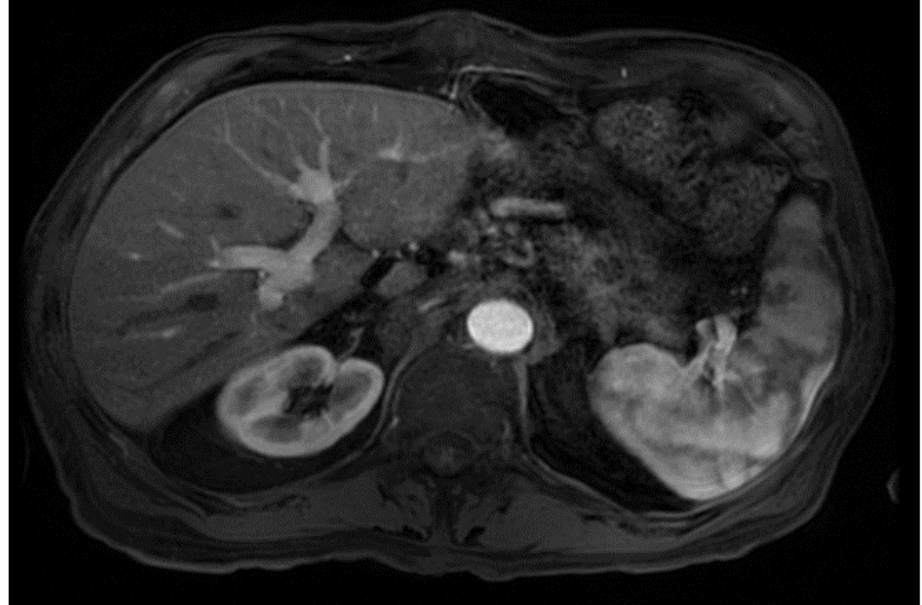
Figure 4. Magnetic resonance imaging of the abdomen. T1 with contrast, orthotopic liver transplant has been successfully achieved, no mass, and the impression is normal (captured at the post-transplant follow-up visit).